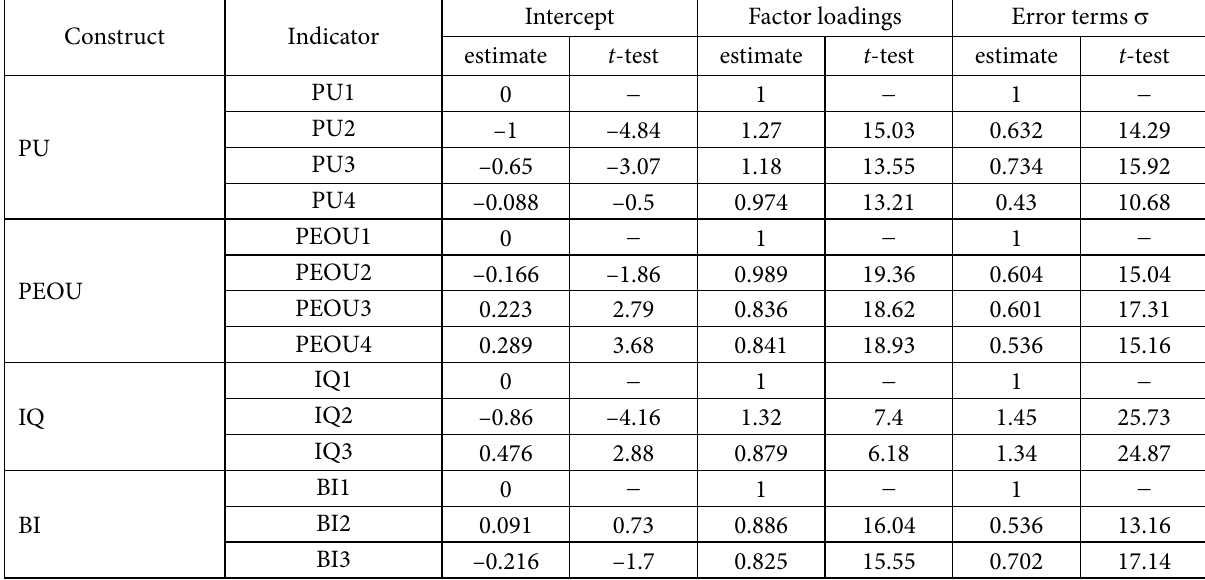
Table 10. Results of the measurement